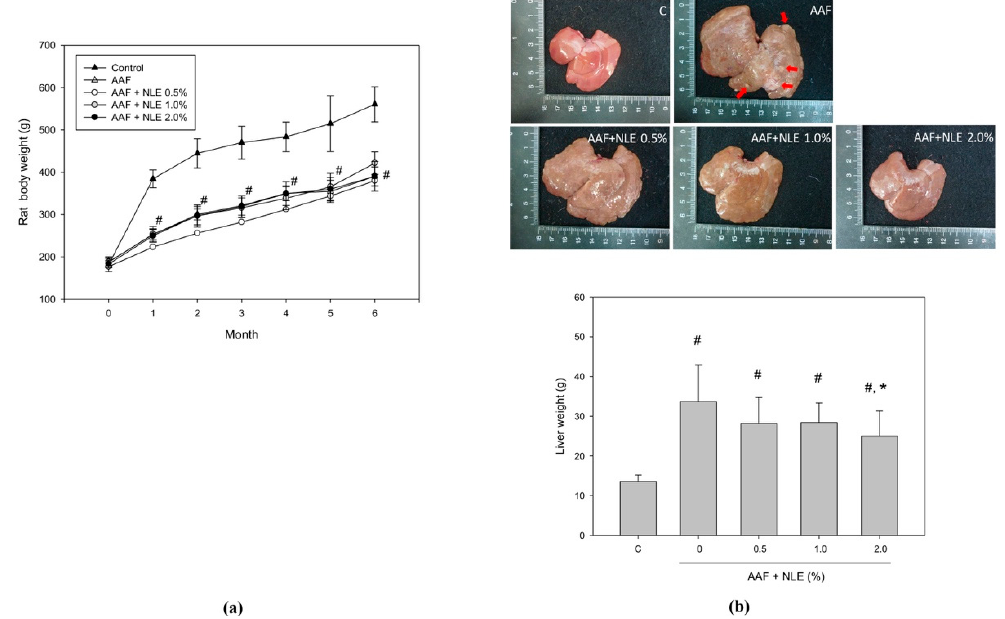
Figure 2. Effect of NLE supplementation on body weight and liver weight in AAF-induced rats. Wistar rats were fed a normal diet (as the C group), a normal diet containing AAF (as the AAF group), normal diet containing AAF (0.03%) with 0.5% NLE (as the AAF + NLE 0.5% group), a normal diet containing AAF with 1% NLE (as the AAF + NLE 1% group), and a normal diet containing AAF with 2% NLE (as the AAF + NLE 2% group) for six months. ( a ) Changes in the body weight of rats in each month. ( b ) After 6 months, the rats were sacrificed and their liver weights were determined. Data are shown as means ± SDs (n = 10); # p < 0.05, compared with the control group and * p < 0.05, compared with the AAF group.